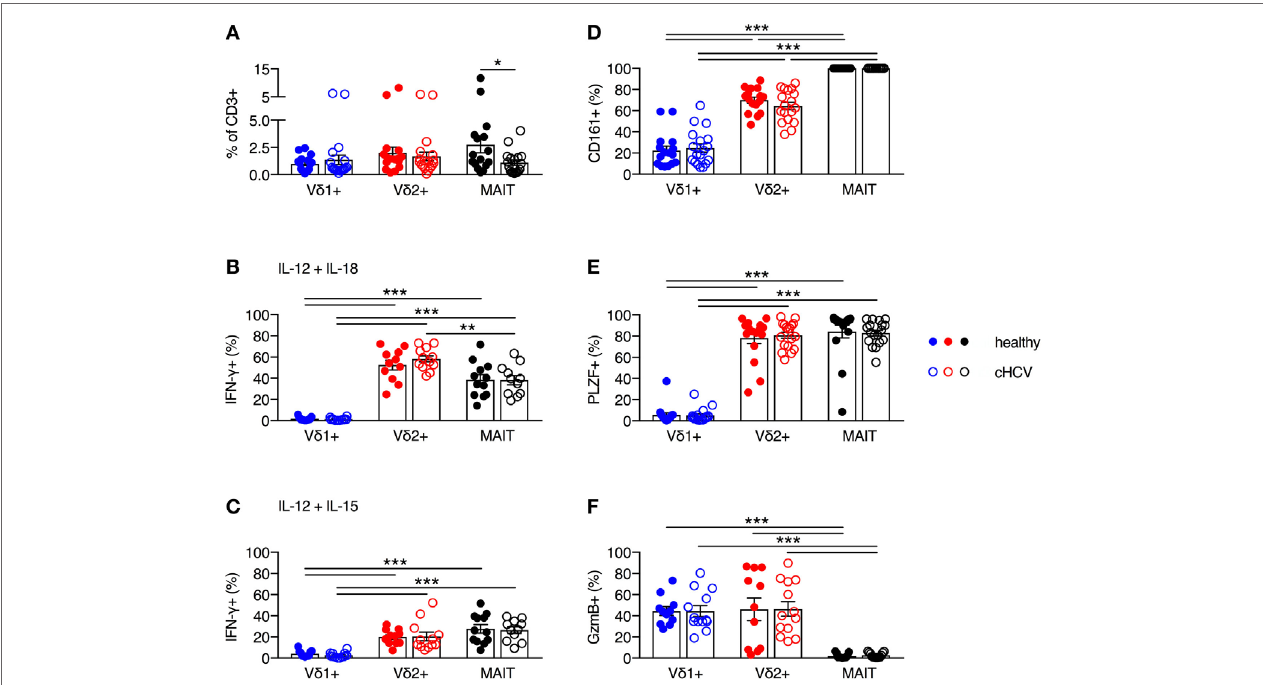
FigUre 6 | Peripheral blood V δ 2 + γδ T cell frequency and cytokine-dependent function is maintained during chronic hepatitis C virus (cHCV) infection. (a) Frequency of V δ 1 + γδ T cells, V δ 2 + γδ T cells, and mucosal-associated invariant T (MAIT) cells as a fraction of all CD3 + T cells in the blood of healthy donors and patients with cHCV. (B,c) Peripheral blood mononuclear cells were stimulated for 20 h with IL-12 and IL-18 (B) , or IL-12 and IL-15 (c) (50 ng/ml). Brefeldin A and Monensin were added for the final 4 h. Production of IFN- γ by each cell subset from healthy donors and HCV patients. (D–F) Expression of CD161 (D) , PLZF (e) , and Granzyme B (F) on V δ 1 + γδ T cells, V δ 2 + γδ T cells, and MAIT cells. Mean ± SEM. Symbols represent individual donors ( N = 11–33). *** P < 0.001; ** P < 0.01; * P < 0.05. (a) T test and (B–F) two-way ANOVA with Tukey’s multiple comparison test.